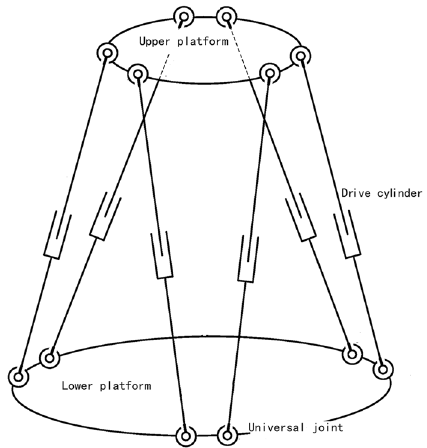
Figure 2. Schematic diagram of the structure of the wave compensation platform.